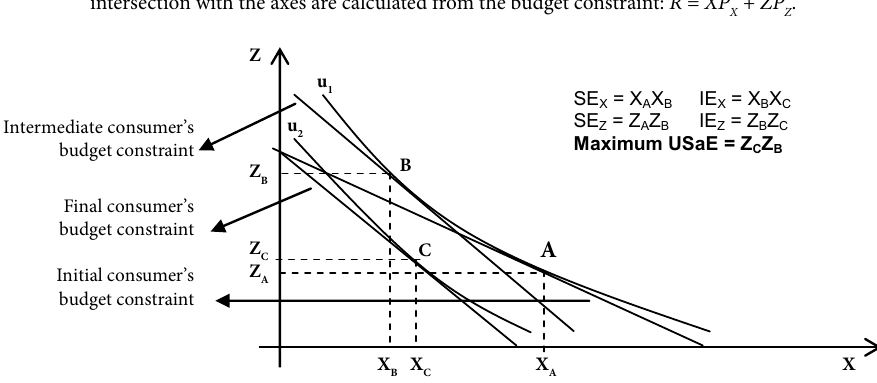
Fig. 3. Graphical representation according to the Hicks’ classical view of the Unsaving Effect when there are two inferior goods and P Notes : Quantities of goods X and Z in the initial, intermediate and final equilibrium situations (A, B and C respectively). X and Z substitution effects (SE (IE and IE ). Unsaving effect (USaE). Initial and final indifference curves (u X Z The points of intersection with the axes are calculated from the budget constraint: R = XP